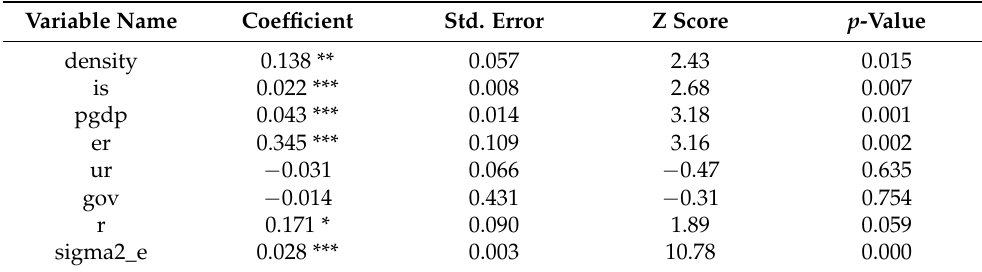
Table 4. Regression results of spatial Durbin model for factors influencing the ULGUE of Lanzhou- Xining urban agglomeration in the Yellow River